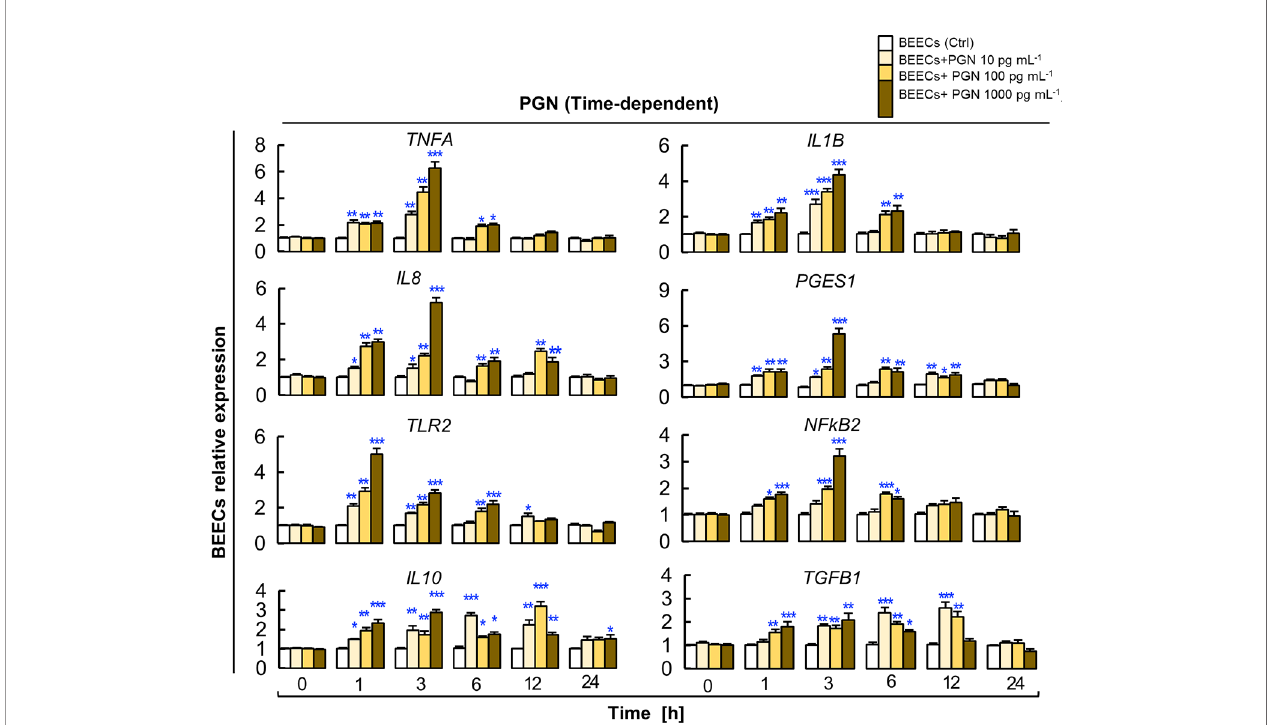
FIGURE 3 | PGN induces transient upregulation of the transcription of major pro- and anti-in fl ammatory markers in BEECs. Subcon fl uent BEEC monolayers were exposed to different picogram concentrations (10, 100 and 1000 pg ml − 1 ) of PGN at different time points (0, 1, 3, 6, 12, and 24 h). The mRNA expression of major pro- and anti-in fl ammatory markers was assessed using RT-PCR assay. Data are presented as mean ± SEM of 3 independent experiments using epithelial cells from 3 different uteri (3 wells/treatment/experiment). Asterisks denote a signi fi cant variance (*P < 0.05 **P < 0.01 , or ***P < 0.001) between the different groups of PGN concentrations (pg/ml) when compared to the control group (0 pg/ml) at each time